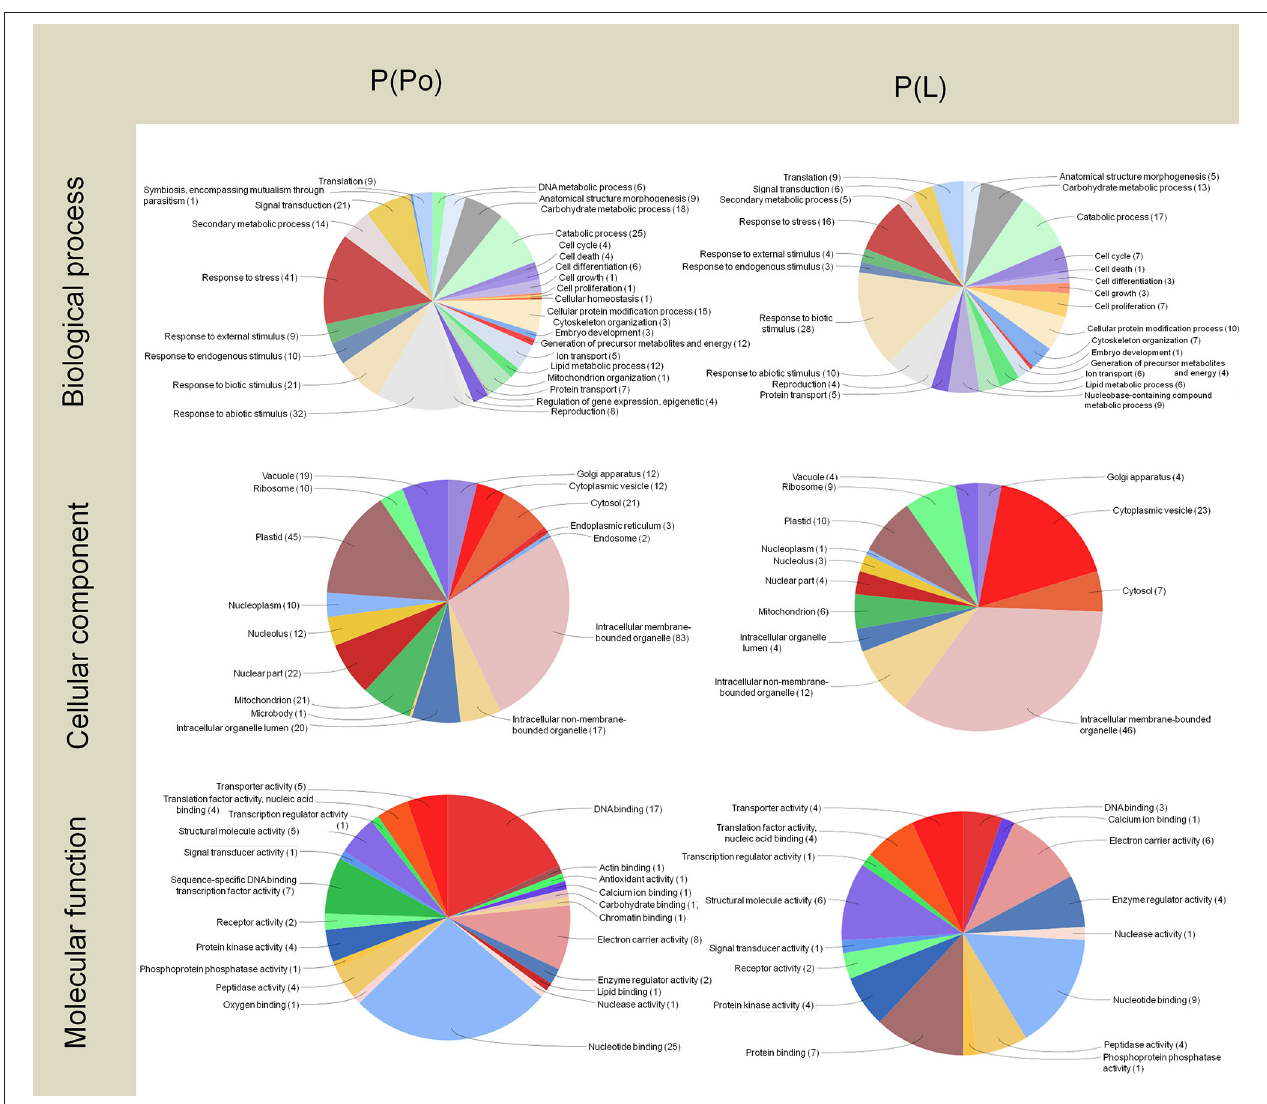
FIGURE 4 | Gene Ontology terms distribution of the P(Po) and P(L) libraries. The distribution of biological processes and molecular function was assessed to a sequence cut off = 1. The distribution of cellular components corresponds to a level = 6. The graphs were prepared using the Blast2Go software.